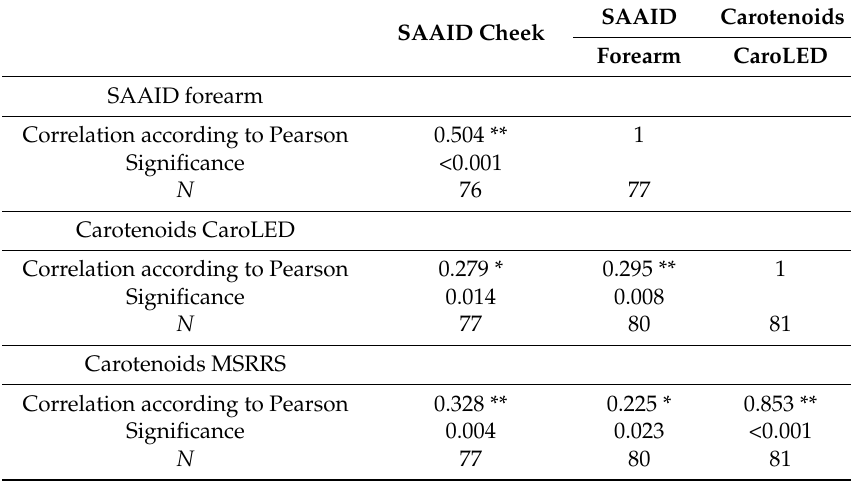
Table 1. Pearson correlation coefficient r with p -values and number of the SAAID and carotenoid values ( N ); * p < 0.05, ** p < 0.01. SAAID Carotenoids SAAID Cheek Forearm CaroLED SAAID forearm Correlation according to Pearson 0.504 **